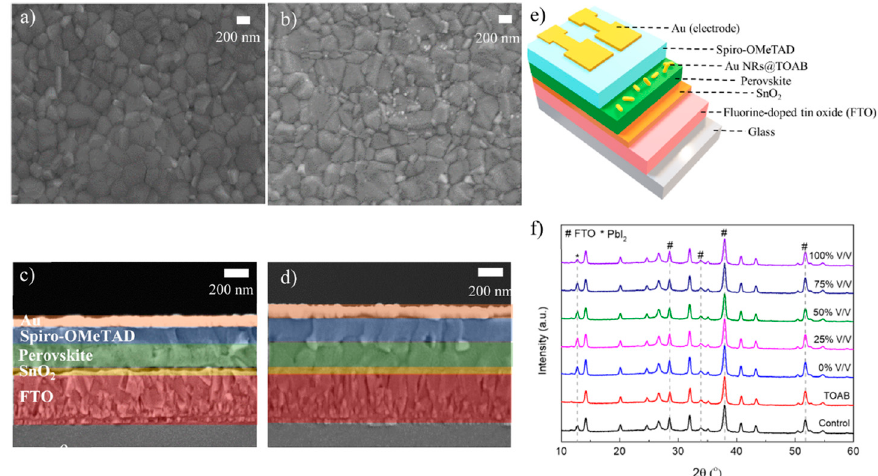
Figure 14. Perovskite without Au NR treatment in top-view and cross-sectional SEM images ( a , c ) and AuNR treatment with perovskite ( b , d ), ( e ) The PSC structure is shown schematically. ( f ) Perovskite film’s XRD pattern as a function of Au NR treatment. 100% v/v denotes no dilution, while v / v indicates the degree of dilution [141].